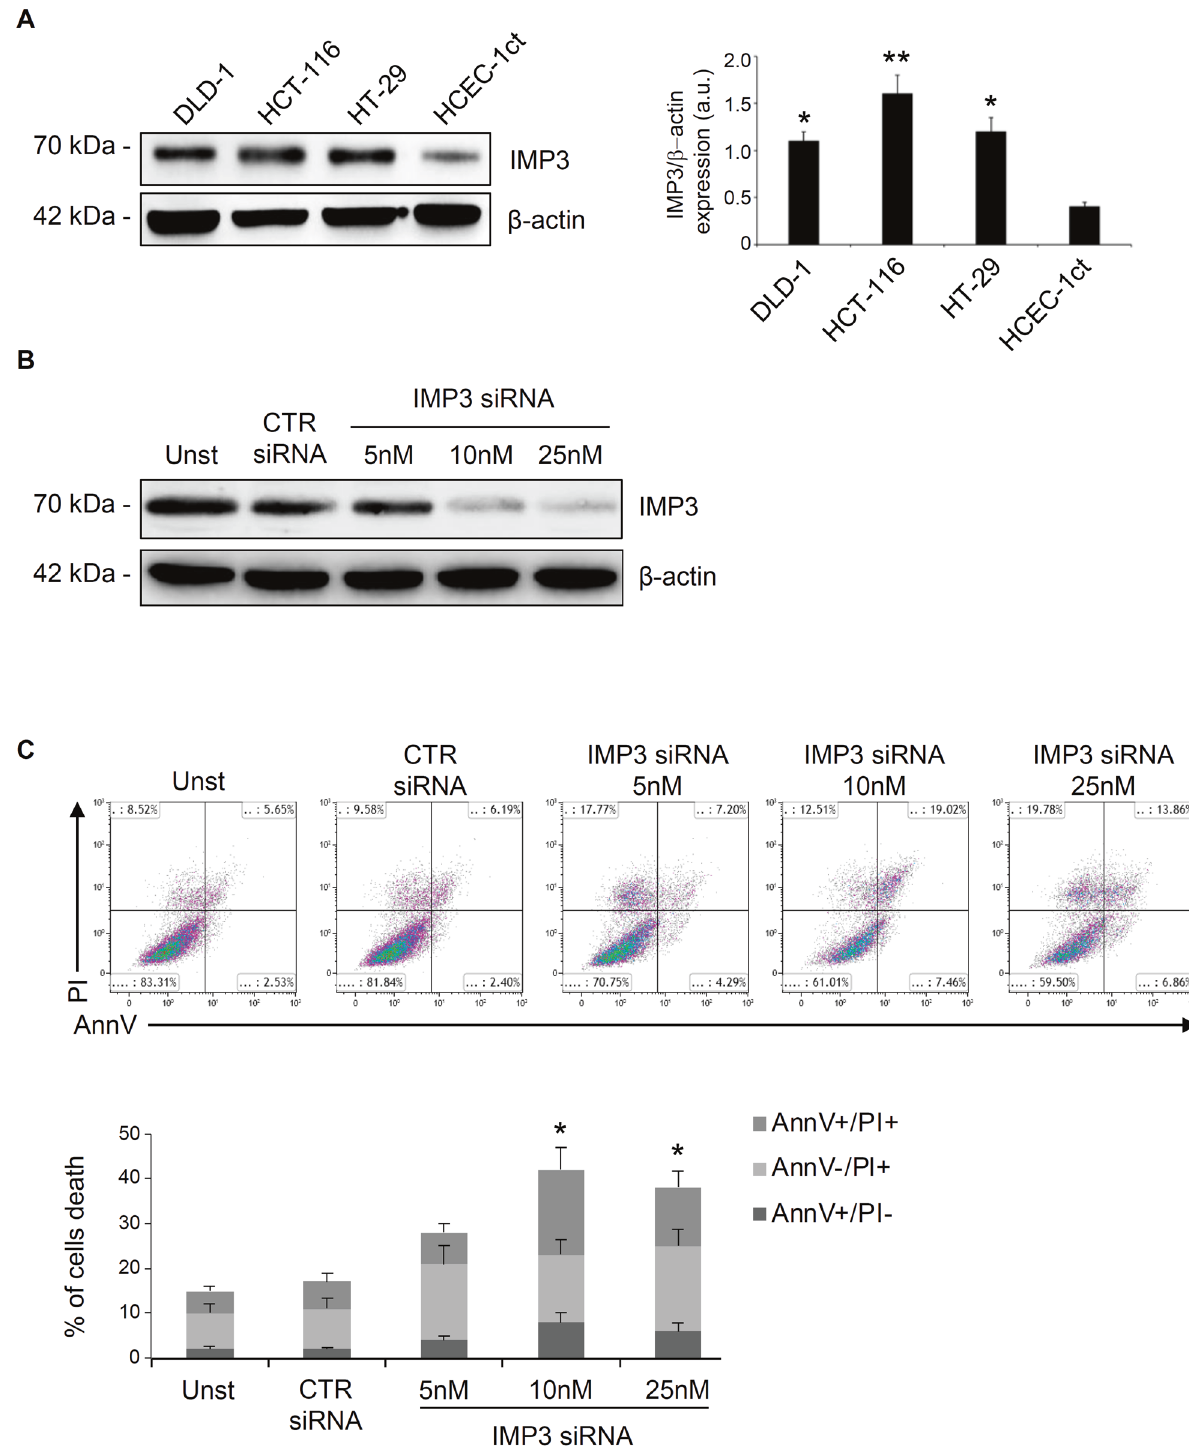
Fig. 2 Knockdown of IMP3 triggers cell death in CRC cell lines. A Left, IMP3 levels in representative images of Western blot from DLD-1, HCT- 116 and HT-29 CRC cell lines and the healthy colon epithelial cell line HCEC-1ct. β -actin was used as loading control. Right, quantitative analysis of IMP3/ β -actin protein ratio as measured by densitometry scanning of Western blots (values are expressed in arbitrary units a.u.; * p = 0.04, ** p = 0.03; mean ± SD, n = 3). B Representative Western blot showing IMP3 expression in HCT-116 cells untreated (Unst) or transfected with control or IMP3 siRNA. C Upper panel, representative dot plot of Annexin V (AnnV) and propidium iodide (PI)-positive HCT- 116 cells treated as indicated above for 48 h. Lower panel, quanti fi cation of the percentage of AnnV and/or PI-positive HCT-116 cells (mean ± SD; AnnV + PI + unst and CTR siRNA-treated cells versus IMP3 siRNA 10/25nM-transfected cells, * p ≤ 0.05, mean ± SD, n = 3).